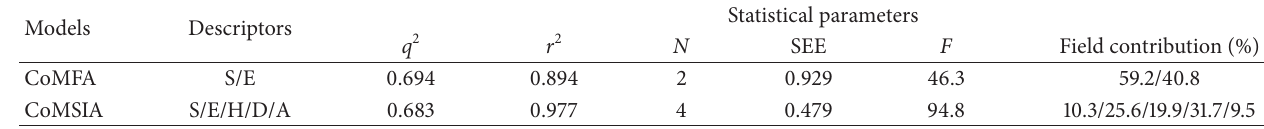
Table 3: Statistical results of CoMFA and CoMSIA models.